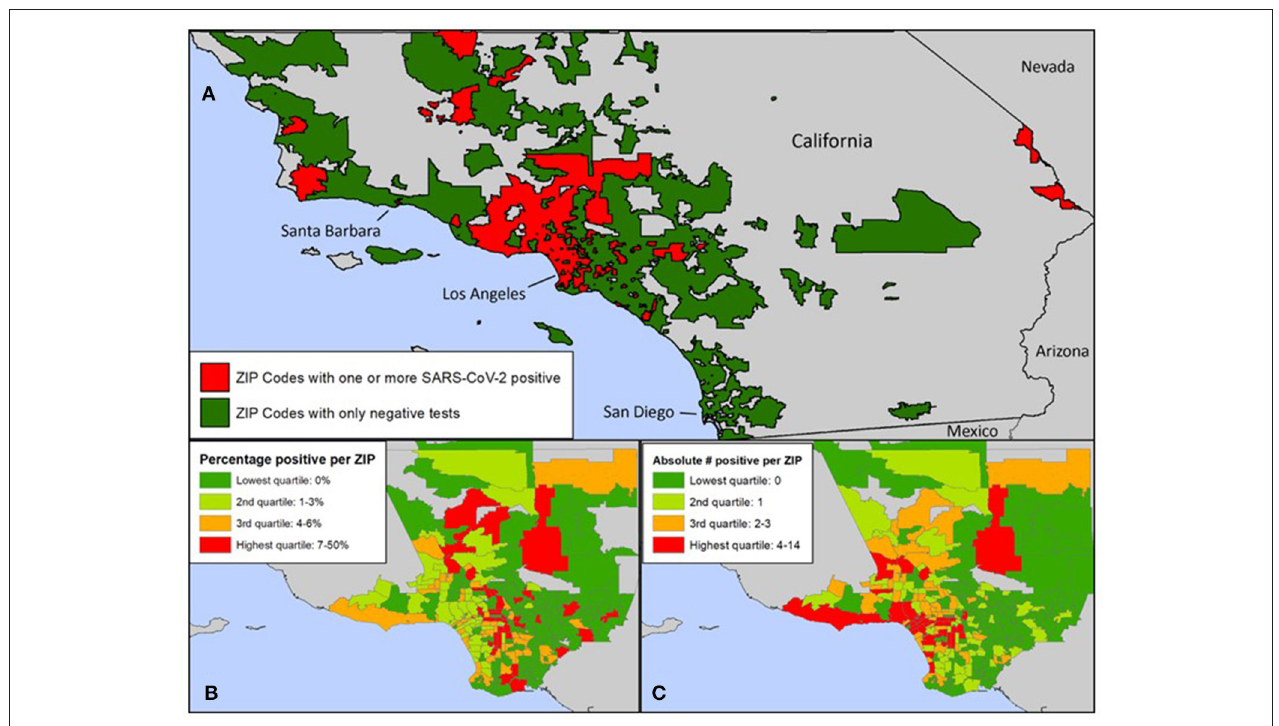
FIGURE 2 | (A) Zip codes in Southern California with SARS-CoV-2 tests at UCLA. (B) Zip codes within Los Angeles County with positive SARS-CoV-2 tests at UCLA: Percentage of positive tests. (C) Zip codes within Los Angeles County with positive SARS-CoV-2 tests at UCLA: Absolute number of positive tests. (A) Zip codes in green reflect residents who were tested at UCLA and were negative. Zip codes in red reflect residents who were tested at UCLA and were positive. (A–C) Zip codes of youth tested for SARS-CoV-2 at UCLA included zip codes in Los Angeles, Santa Barbara, Ventura, San Bernardino, Riverside, San Diego, and Orange Counties. The number of cases of SARS-CoV-2 positive youth under 25 per zip code was significantly associated with the proportion of residents who identified as